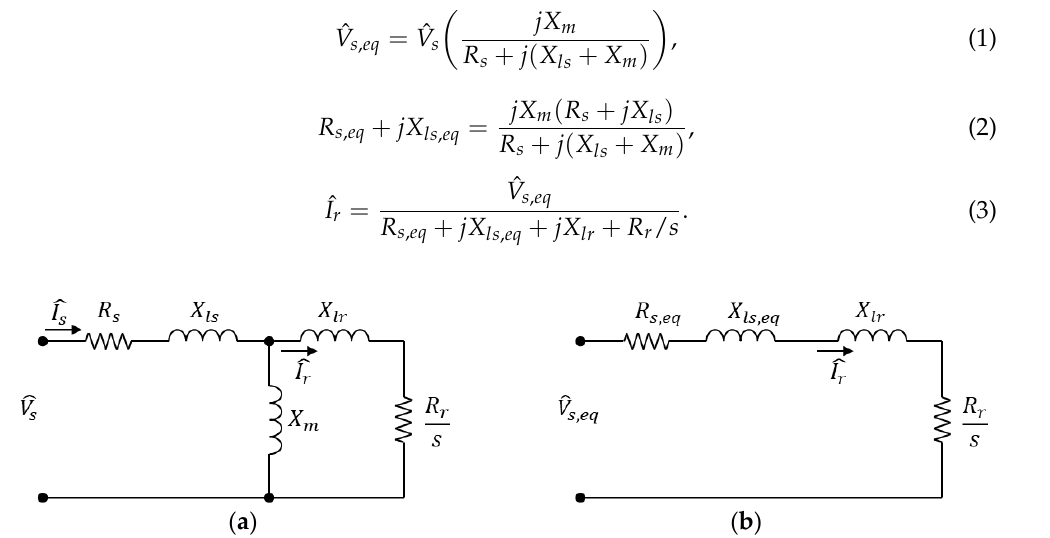
Figure 1. Single-phase equivalent circuit of induction motor ( a ) fully described and ( b ) simplified by Thevenin’s theorem.